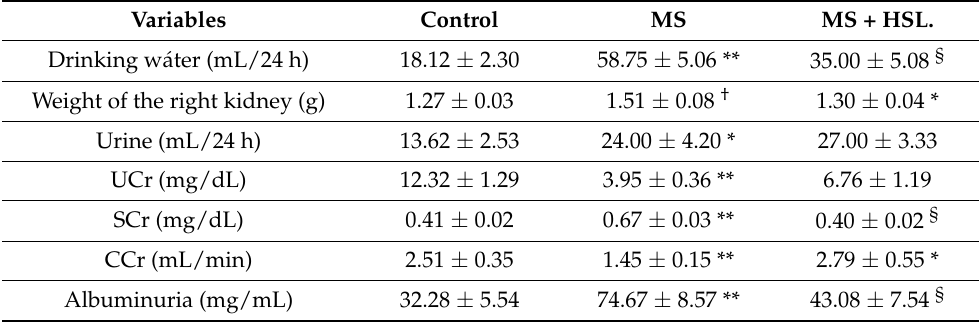
Table 2. Renal function indicators in the experimental groups.